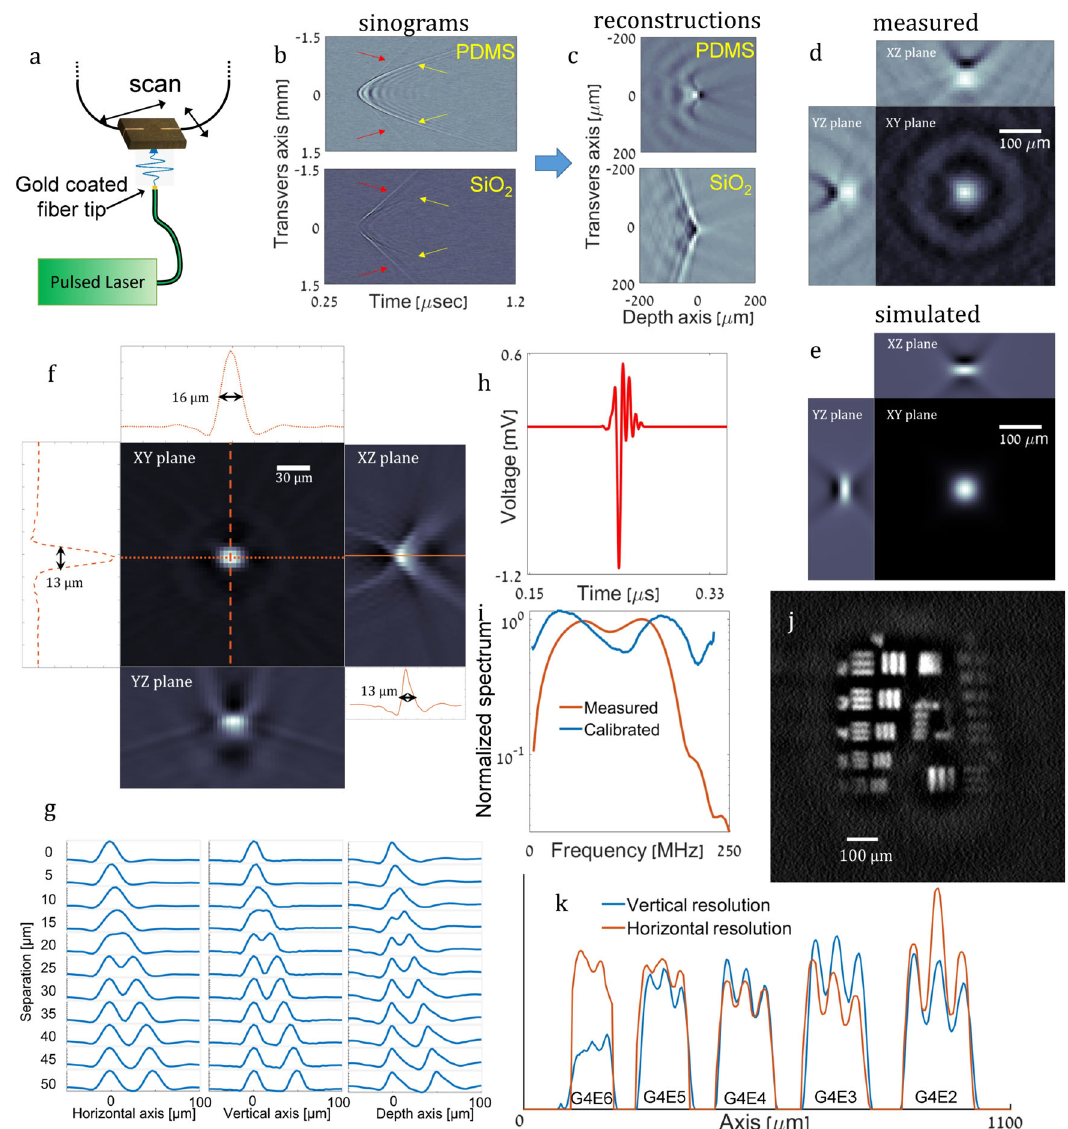
Fig. 4 Performance of SPADE. a Schematics of the experimental system in which an optoacoustic point source was created by illuminating the gold-coated tip of an optical fi ber with optical pulses. b Sinogram measurements were obtained with SPADE with PDMS over-cladding (top) and Si0 2 over-cladding (bottom), where the coated- fi ber source had a core diameter of 50 µ m. Red arrows mark surface acoustic waves, yellow arrows mark direct-impact acoustic waves. c Corresponding 2D optoacoustic reconstructions obtained from the sinograms of b . d 3D Reconstruction cross-sections obtained for the measurement and simulation ( e ) of the 50 µ m source. f Reconstruction cross-section of the 10 µ m source and corresponding 1D slices, revealing reconstruction transversal widths of 13 µ m and 16 µ m, and depth of 13 µ m. g Separation simulation of two 10 µ m sources at different distances for horizontal, vertical, and depth shifts. h Acoustic signal measured by the PDMS-coated SPADE for a coated- fi ber source with a core diameter of 10 µ m. i The spectrum of the acoustic signal presented in h (red) and the calibrated spectrum. j Reconstruction of resolution target 1951 USAF groups 4 – 7. k one- dimensional cross-sections of resolution target, G marks group number, and E marks the element